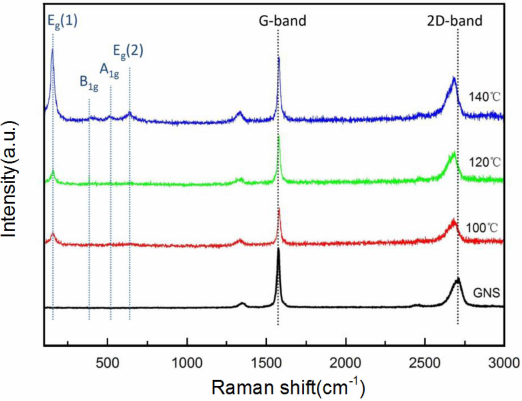
Figure 1. Raman spectra of GNs and the TiO 2 /GNs samples in different hydrothermal temperatures.